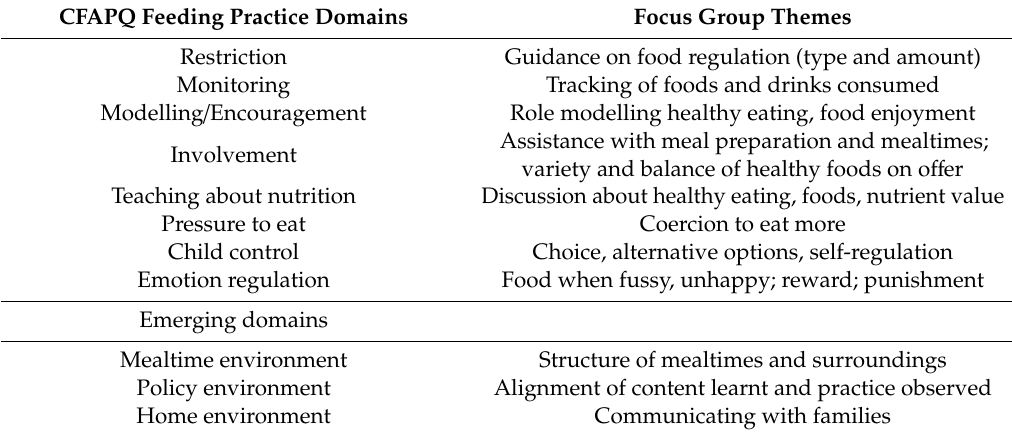
Table 2. Focus group themes mapped to CFAPQ and emerging